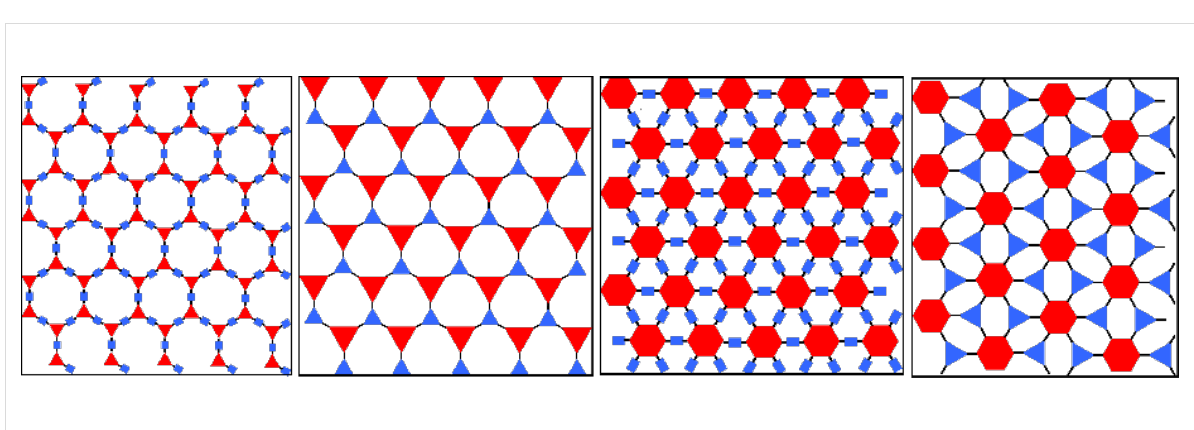
Figure 2: Topologies of 2D COFs considered in this work: (from the left) Tl, Tt, Hl, and Ht. Red and blue blocks are secondary building units corres- ponding to connectors and linkers, respectively.